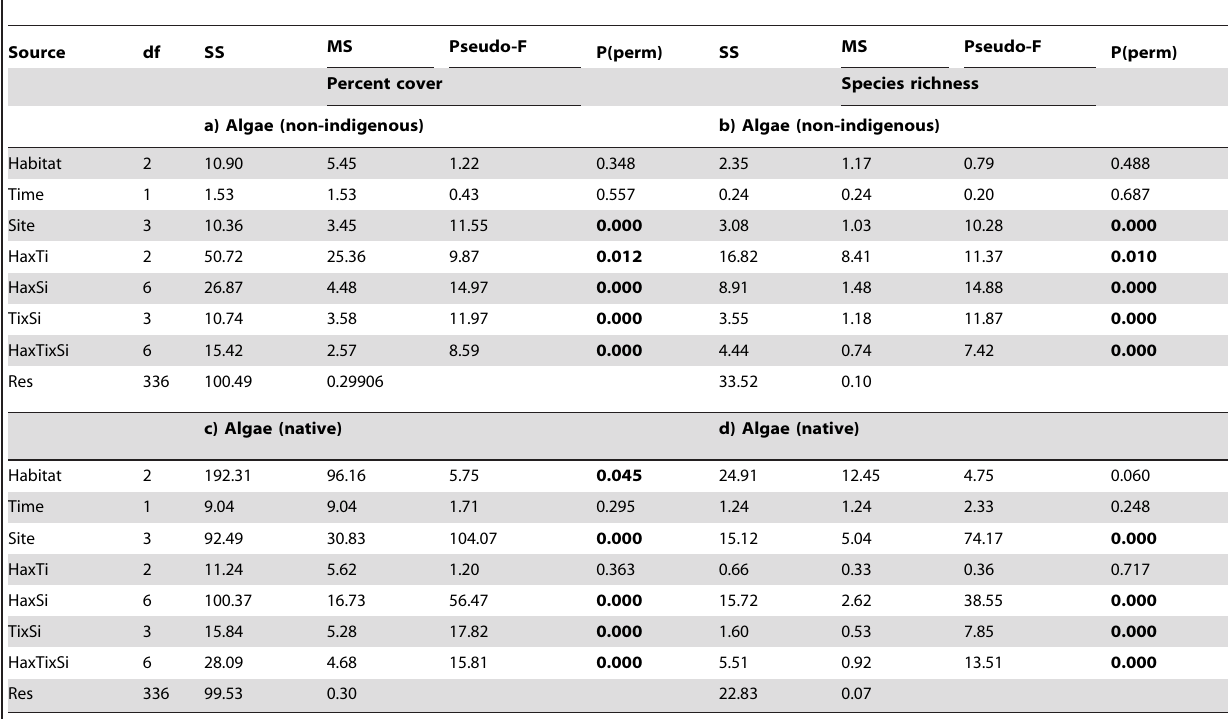
Table 3. PERMANOVA results comparing non-indigenous and native algal species percent cover and richness sampled from artificial and natural